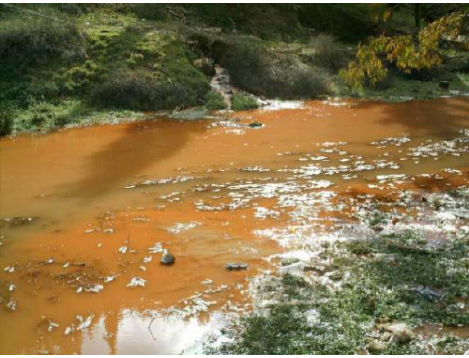
Figure 9. Reddish leakage water downstream of Hammam Grouz dam photo taken at the right bank